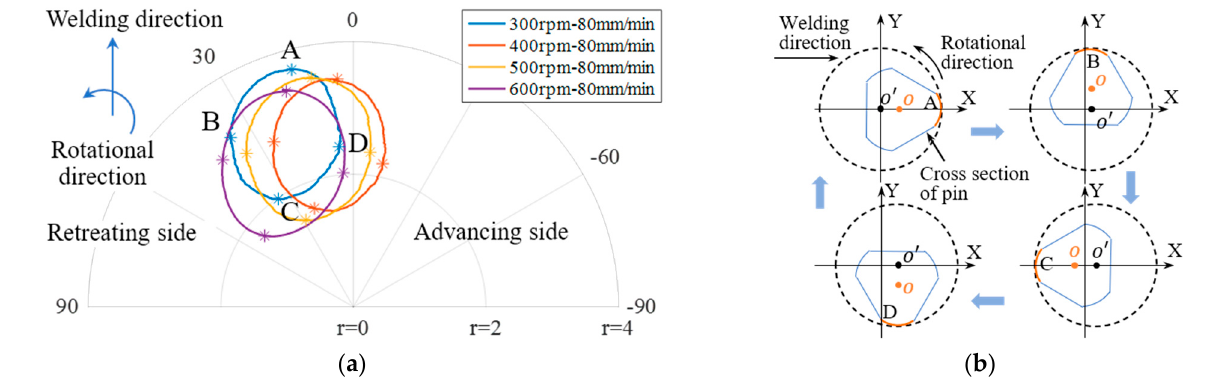
Figure 13. Polar coordinates of in-plane forces: ( a ) at different rotational speeds (with welding speed of 80 mm/min); ( b ) interpretation of the detail in ( a ).